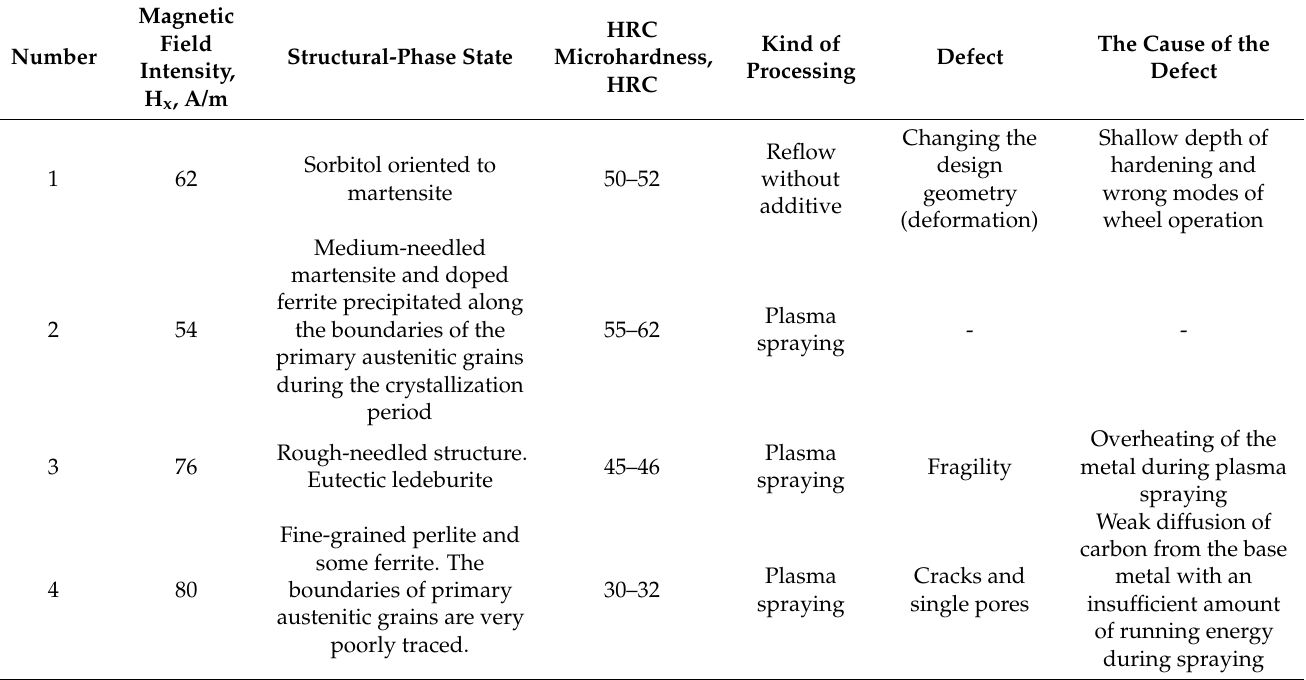
Table 3. The results of the investigation of the causes of the stressed state of the structure of the metal of the wheel.